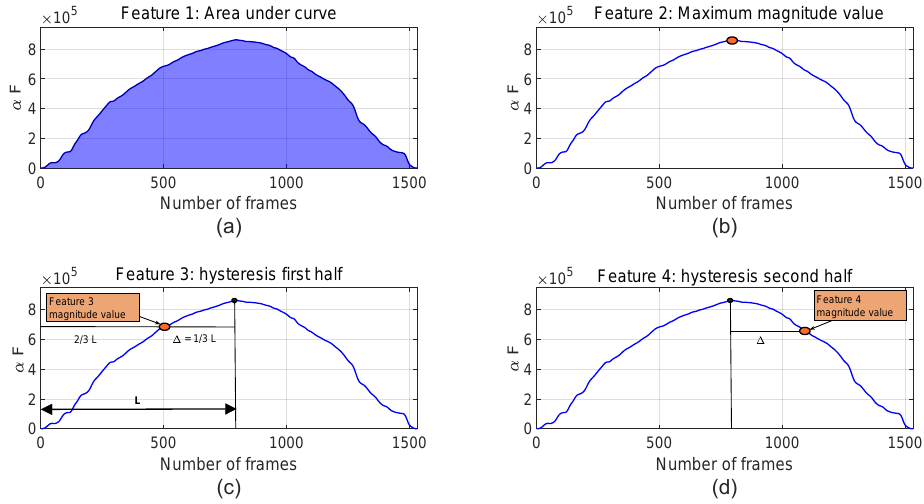
Figure 1. Proposed features for the moment M 0,0 and the object #OBJ-2 (potato): ( a ) area under the curve ( AR feature), ( b ) maximum value ( MAX feature), ( c ) magnitude value in the ascending part at 2/3 of the time to reach the maximum ( H 1 feature), and ( d ) magnitude value at 1/3 of the same time after the maximum is reached ( H 2